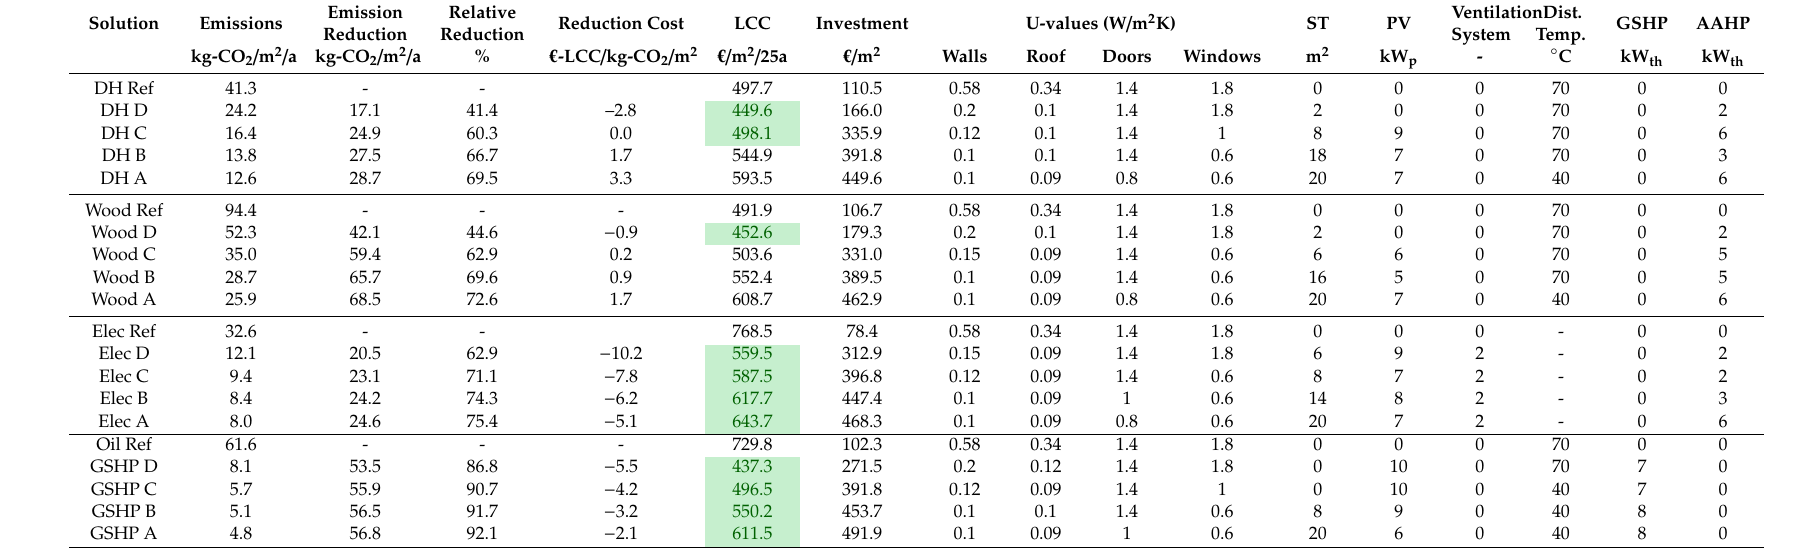
Table 11. Selected optimal cases for SH1 with all heating systems. Cost-e ff ective solutions are marked in green. Cases D to A are optimized solutions from the lowest to the highest life cycle cost (LCC). For the ventilation system: 0 is natural ventilation, 1 is mechanical supply and exhaust ventilation with 75% heat recovery (HR) e ffi ciency, and 2 is mechanical supply and exhaust ventilation with 75% HR and